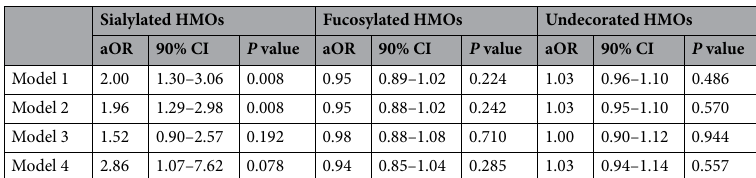
Table 2. Association of sialylated, fucosylated, and undecorated HMOs with severe acute malnutrition among young infants using firth logistic regression. For model 1: adjusted odds ratio (aOR) (90% CI) was adjusted for age and sex. For model 2: adjusted odds ratio (aOR) (90% CI) was adjusted for age and sex and secretor status. For model 3: it was for secretor mothers only and adjusted odds ratio (aOR) (90% CI) was adjusted for age and sex. For model 4: it was for non-secretor mothers only and adjusted odds ratio (aOR) (90% CI) was adjusted for age and sex. Abbreviations: aOR, adjusted odds ratio; CI, confidence interval, HMO, human milk